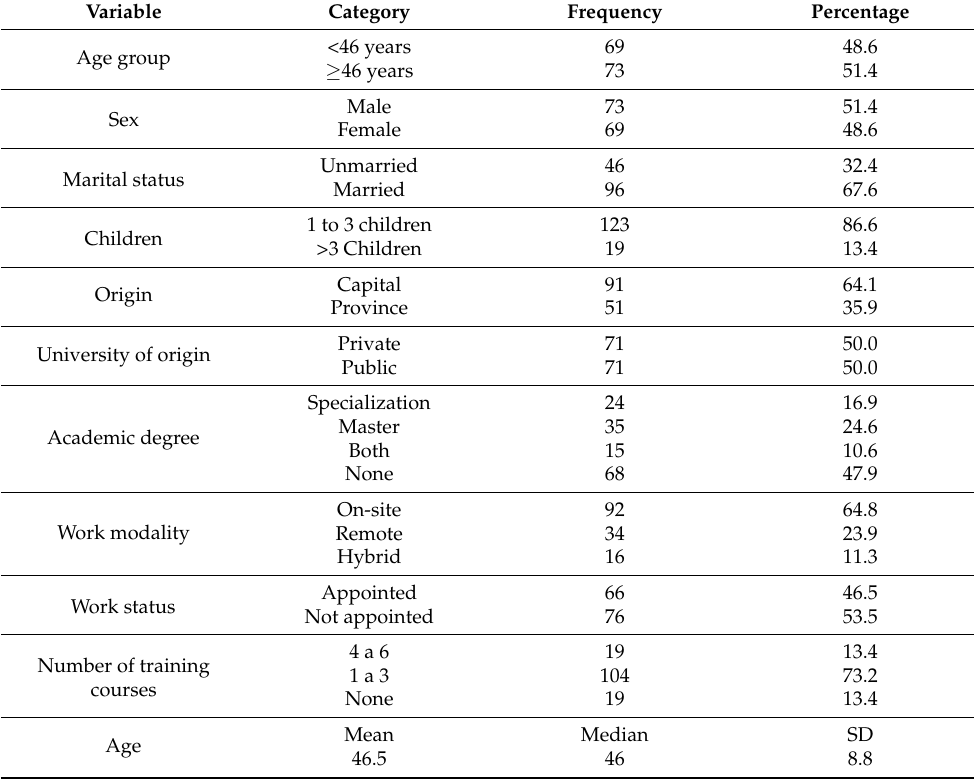
Table 2. Characterization of sociodemographic factors of DIRIS Lima Norte